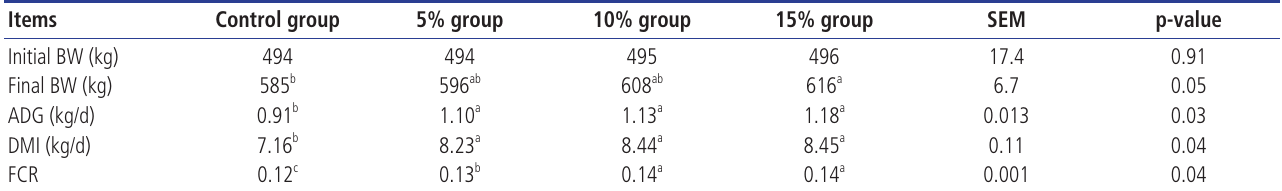
Table 3. Effect of Broussonetia papyrifera silage on performance of black Angus